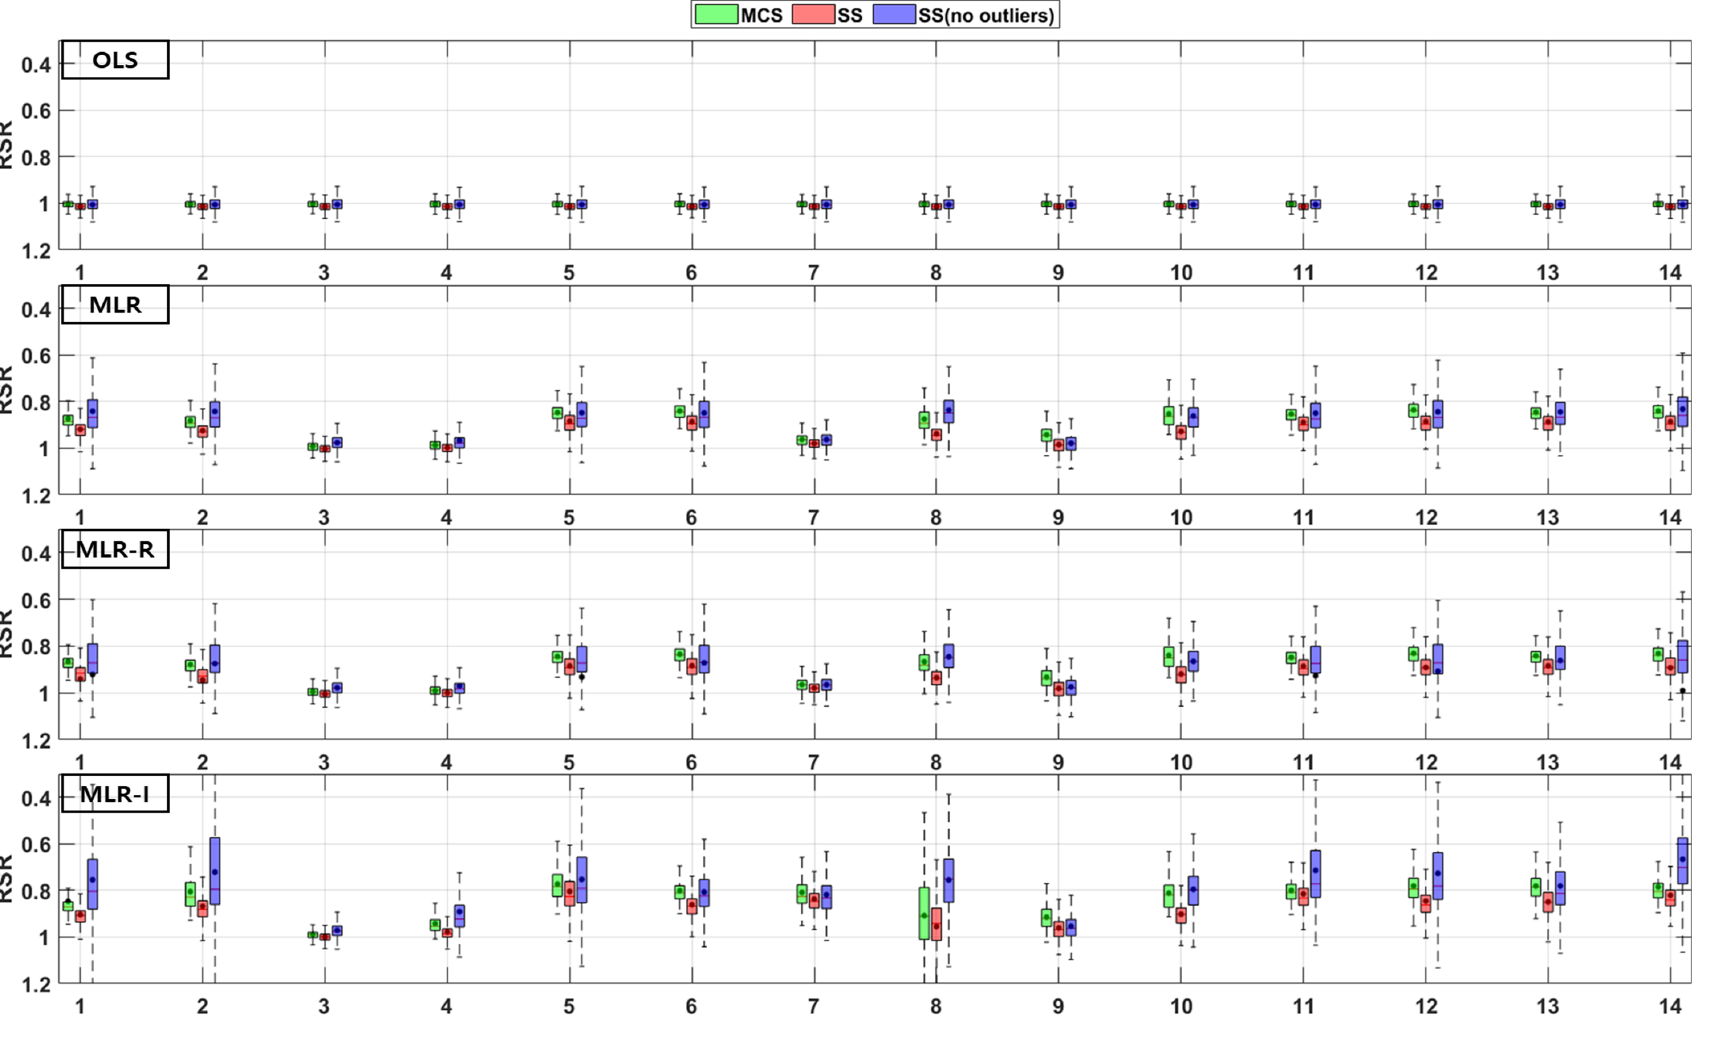
Figure 11. Error analysis (RSR) results of TSS removal in retention ponds.